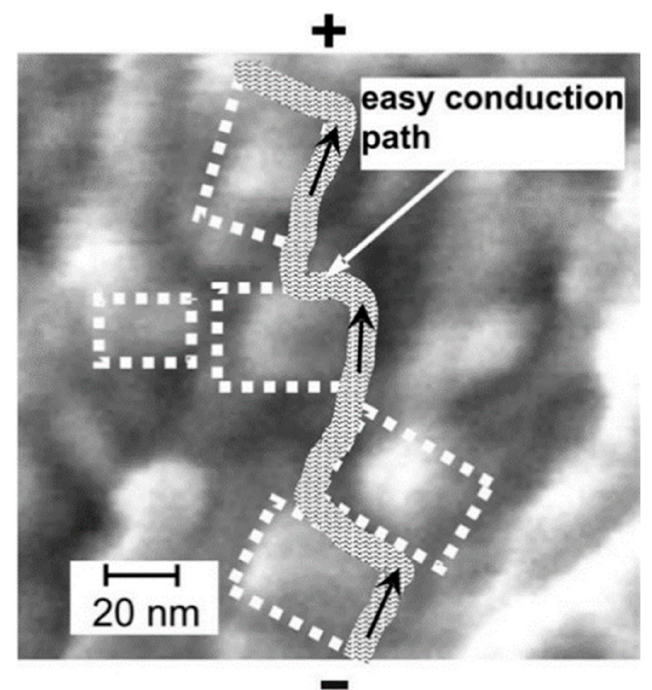
Figure 4. SEM image of a nanocrystallized 90 V 2 O 5 · 10P 2 O 5 glass with a sketch of an easy conduction path along the interfacial regions next to the crystallites (lighter spots) (Reproduced with permission from ref. [35]. Copyright 2011,